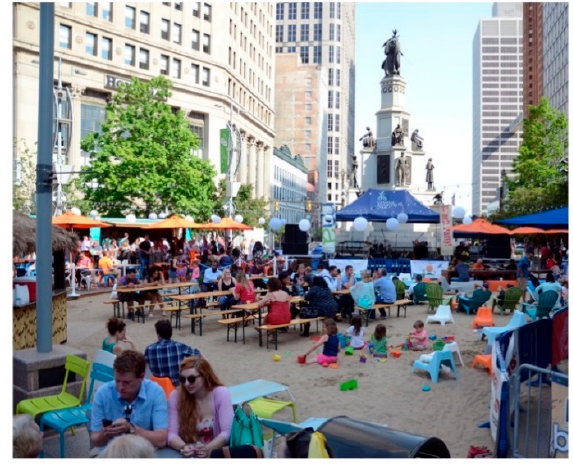
Figure 5. Campus Martius, a renewed public space in central Detroit. Source: photo by authors (9 June 2016).